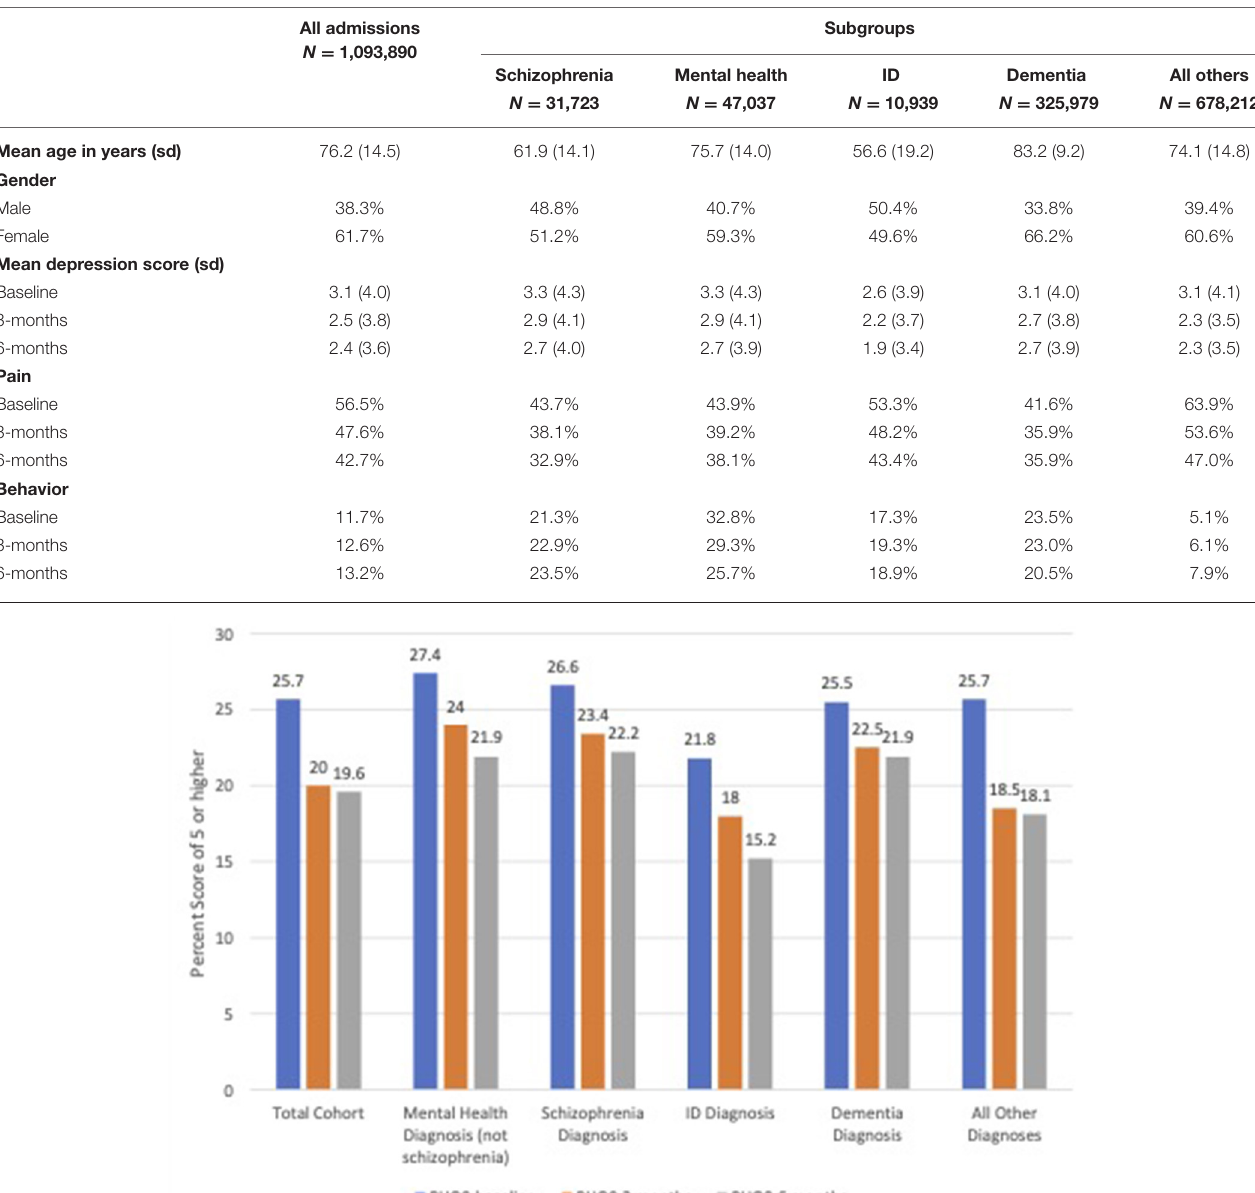
TABLE 1 | Study population characteristics overall and by diagnostic group.